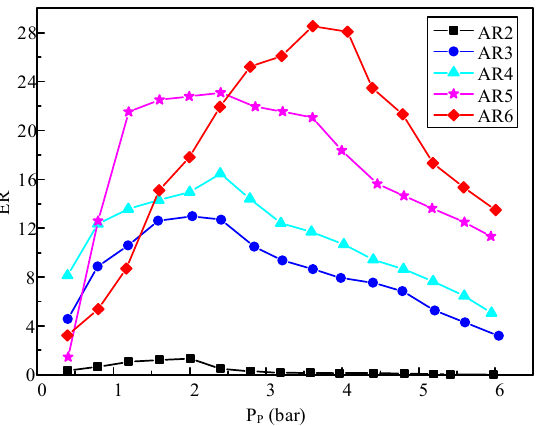
Figure 5. E ff ects of primary flow pressure on ejector performance at various area ratios Figure 5. Effects of primary flow pressure on ejector performance at various area ratios (ARs).